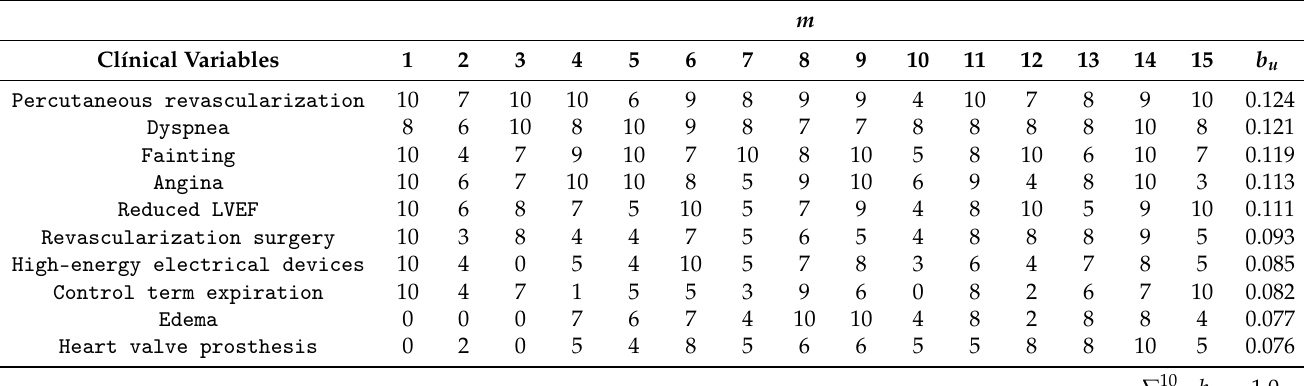
Table 4. Relevance scores assigned by the 15 physicians to the 10 clinical variables.